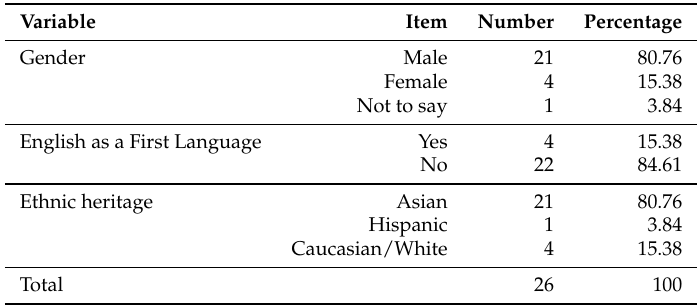
Table 2. Demographic information for the